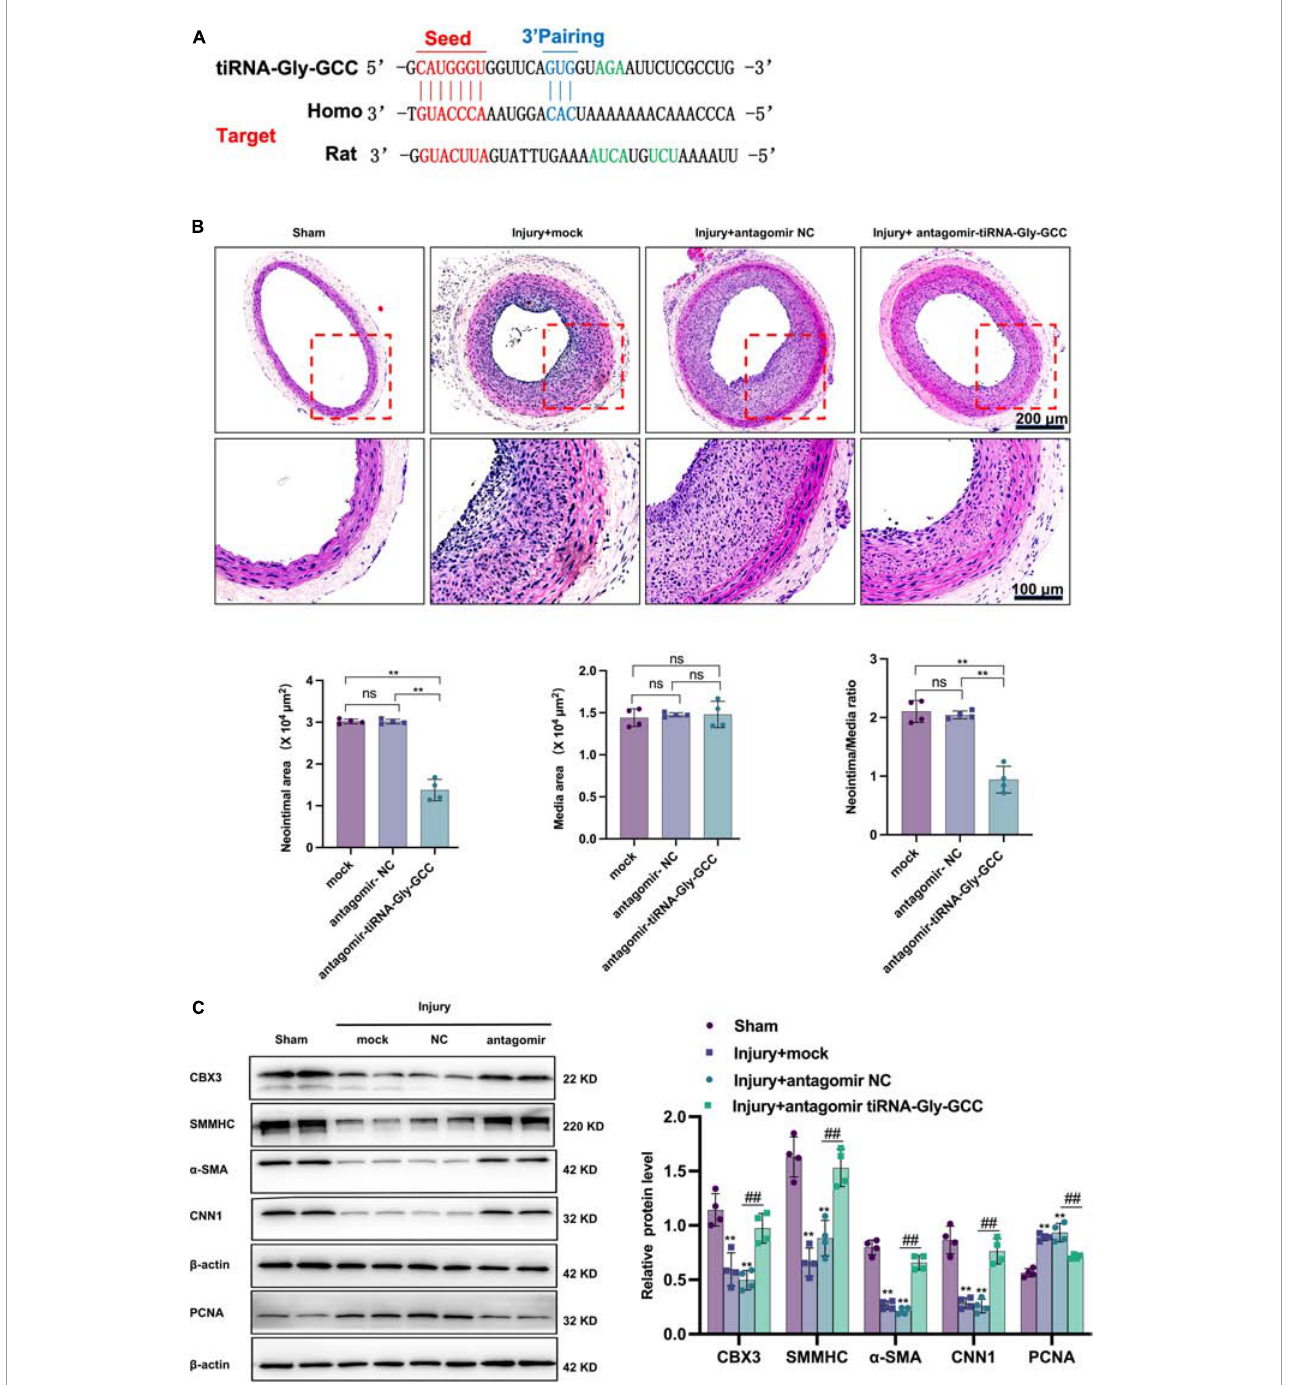
FIGURE7 Inhibition of tiRNA-Gly-GCC reduced neointimal formation after vascular injury by targeting CBX3. (A) The binding sites of tiRNA-Gly-GCC within the CBX3 3 (cid:48) UTR of humans and rats. (B) The upper panel refers to representative HE staining of rat carotid arteries treated with PBS (mock) or antagomir NC or antagomir-tiRNA-Gly-GCC 14 days after injury. The lower panel refers to quantification results of neointimal area, media area, and neointimal/media ratio, from four independent experiments. Data are presented as the mean ± SD. n = 4, **p < 0.01, ns: not significant, compared with the two groups, which are labeled by a horizontal line. Scale bar, 200, 100 µ m. (C) The left panel refers to representative image of Western blot analysis for the expression of CBX3, VSMC-specific proteins (SMMHC, α -SMA, and CNN1) and PCNA in the sham, mock, antagomir NC, and antagomir-tiRNA-Gly-GCC groups. The right panel refers to densitometric quantification of these proteins expression normalized by β -actin, from four independent experiments. Data are presented as the mean ± SD. n = 4 for each group, **p < 0.01 (versus sham group). ## p < 0.01 compared with the two groups, which are labeled by a horizontal